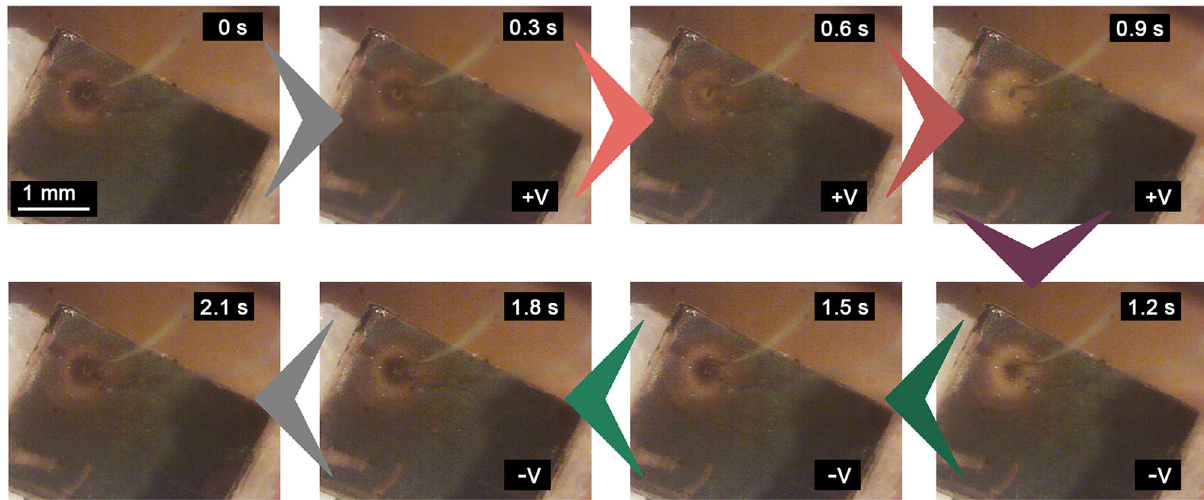
Fig. 2 Snapshots extracted from the Supporting Movie S2 (see ESI). This series of photos demonstrates the time-scale and reversibility of the voltage-dependent discoloration/coloration of the thin conducting layer of the BL fi lm. Applied bias was + 5 V during the discoloration, and − 5 V during the recovery